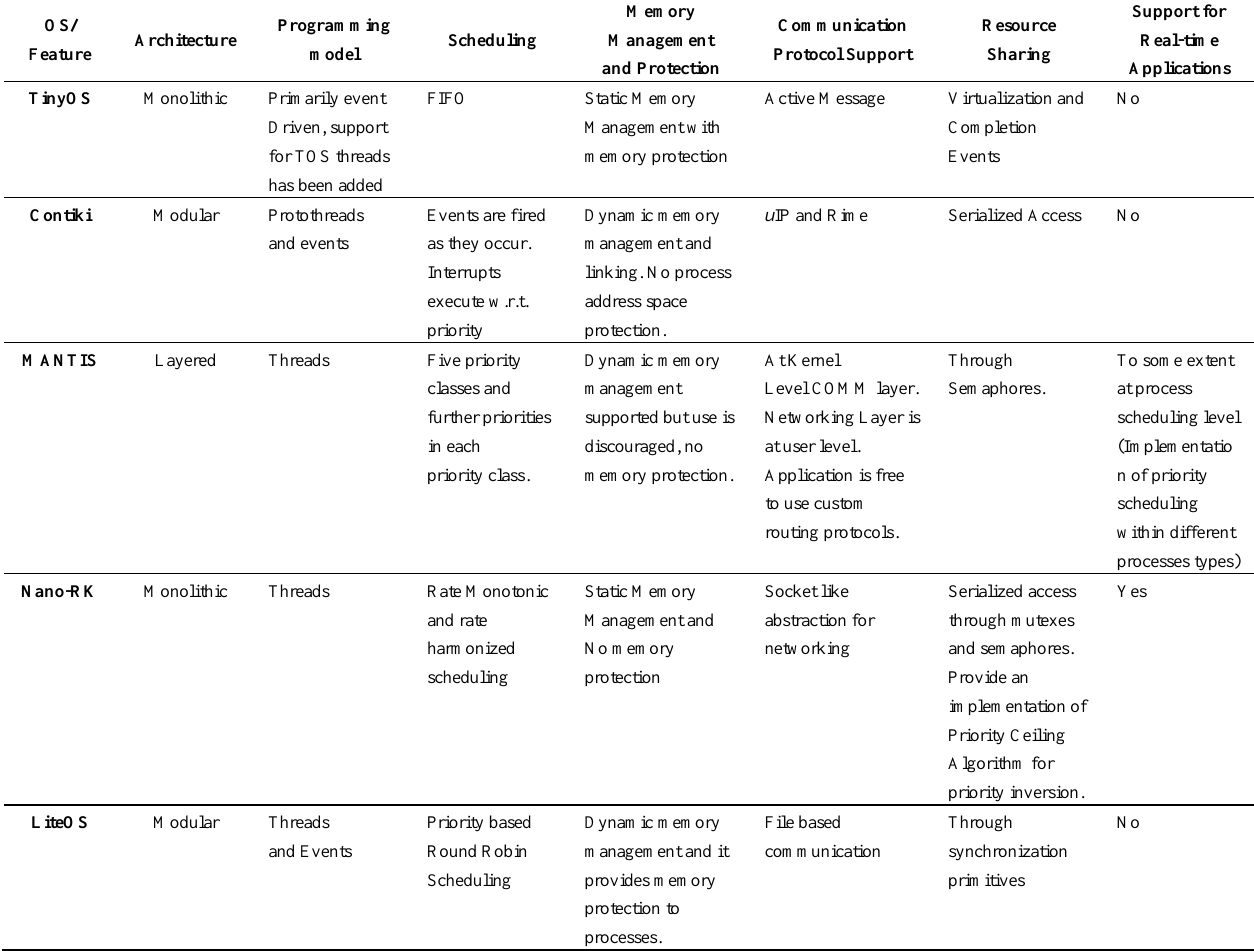
Table 1. Operating Systems Summary.